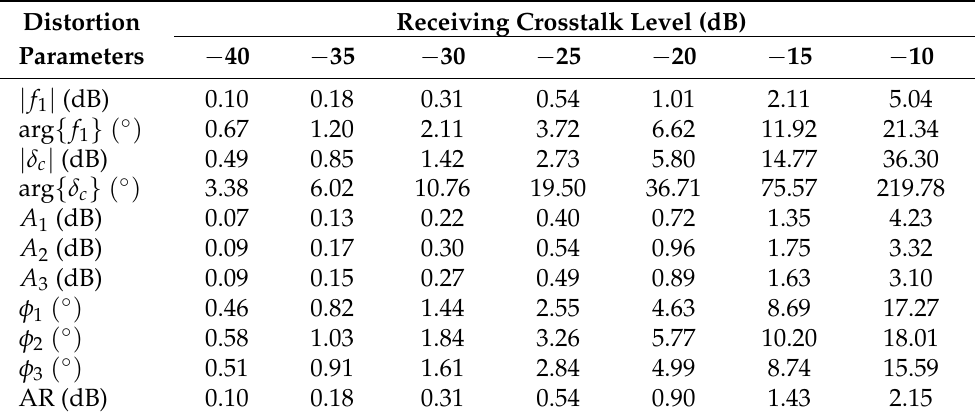
Table 1. The maximum estimation error of the distortion parameters obtained using the ICT scheme under different crosstalk levels.